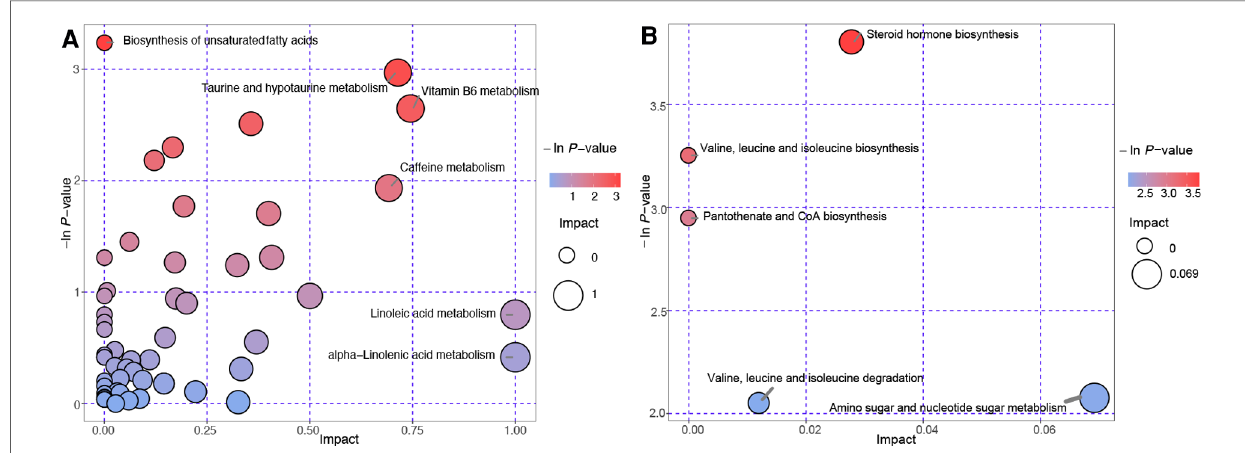
FIGURE 5 Bubble plots of the pathway analysis. Each bubble indicates a metabolic pathway. Control group vs. the non-VC group ( A ). Non-VC group vs. the VC group ( B ). The abscissa and size of the bubble represents the impact in the topological analysis of the pathway. The ordinate and color of the bubble represents the P -value (negative natural logarithm) in the enrichment